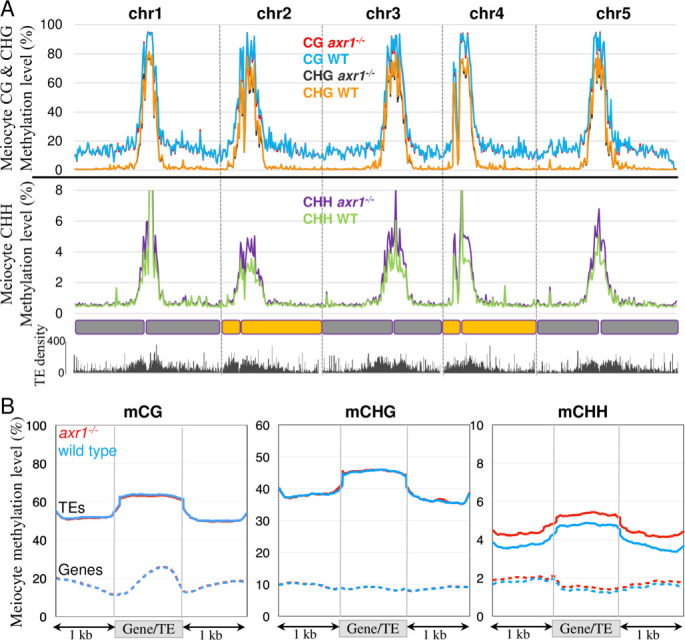
Patterns of DNA methylation in male meiocytes.A: Methylation along chromosomes, calculated from non-overlapping 200 kb bins. The average methylation levels were determined by combining the biological replicates for each genotype. B: Patterns of methylation in genes and TEs in the Col-0 wild type (blue lines) and the axr1-/- mutant (red lines). The average methylation level of genes and TEs was determined by dividing the corresponding annotated regions into 100 bp bins. Regions located 1 kb upstream and 1 kb downstream of the gene bodies or TEs are shown. The average methylation levels were determined by combining the biological replicates for each genotype.